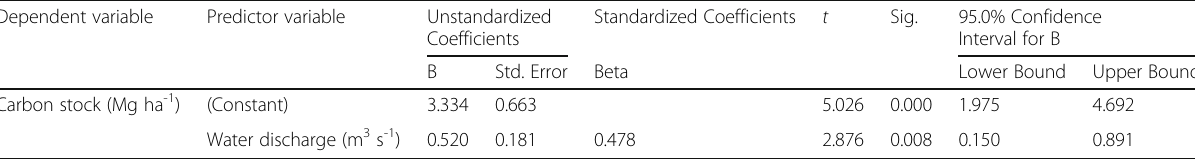
Table 7 Results of multiple regression analysis (using backward method) for carbon stock in wetland vegetation against the micro- topography and water flow regime in the